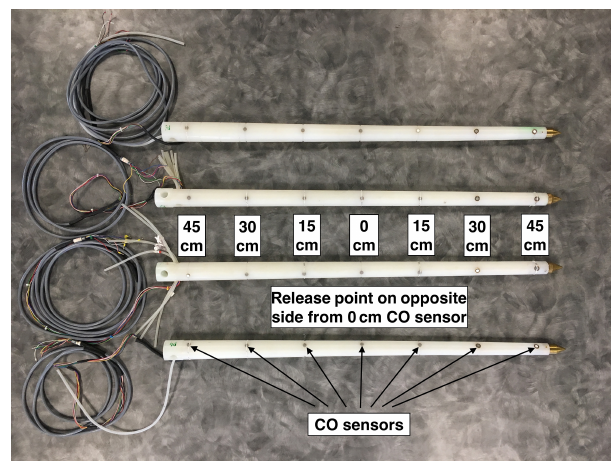
Figure 1. Four 1m snow pickets, each mounted with 7 CO sensors at 15cm spacing. Along-picket distances of the CO sensors from the central CO sensor are labeled in the picture. Carbon monoxide was released through tubing that exited the picket opposite the central (0cm) CO sensor on one of the